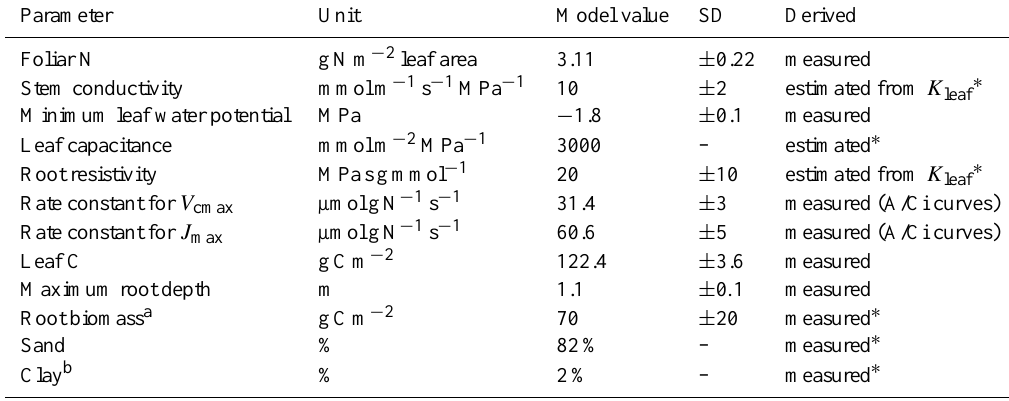
Table 1. Key parameter values for the soil–plant–atmosphere model.